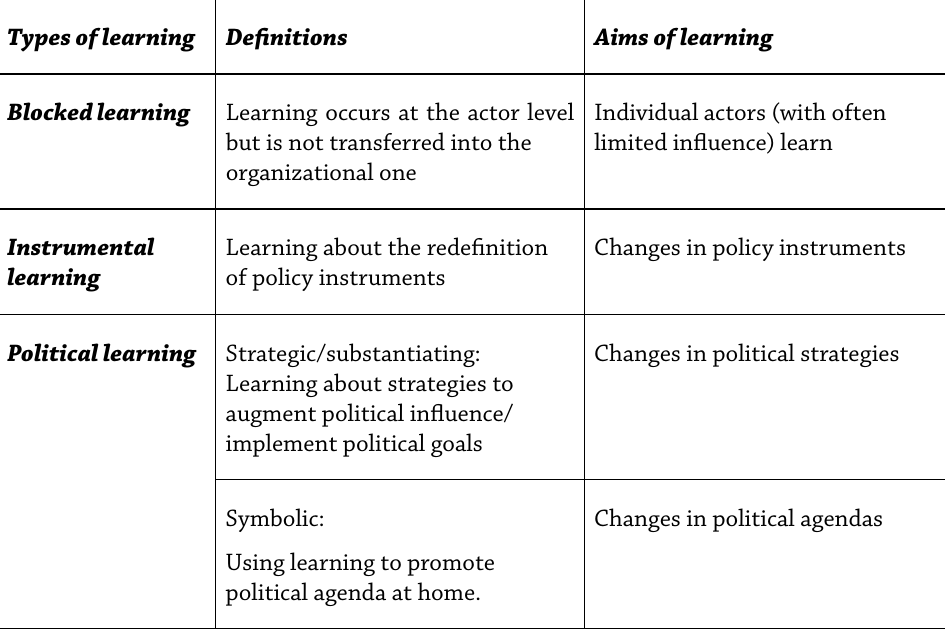
Table 1: Policy learning types Types of